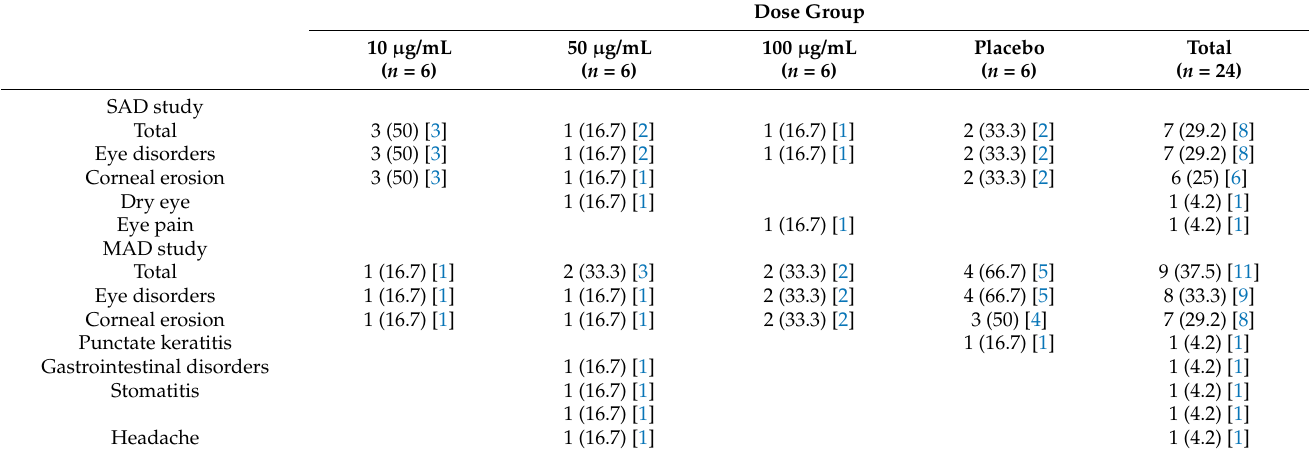
Table 1. Summary of adverse drug reactions for rhEGF eyedrop and after single and multiple administration of rhEGF eyedrop and